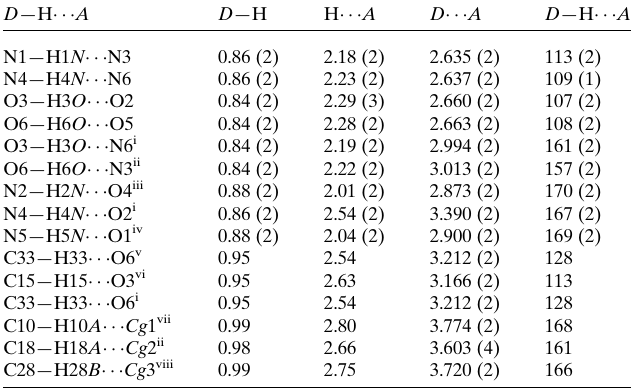
Table 1 Hydrogen-bond geometry (A˚ , (cid:2)